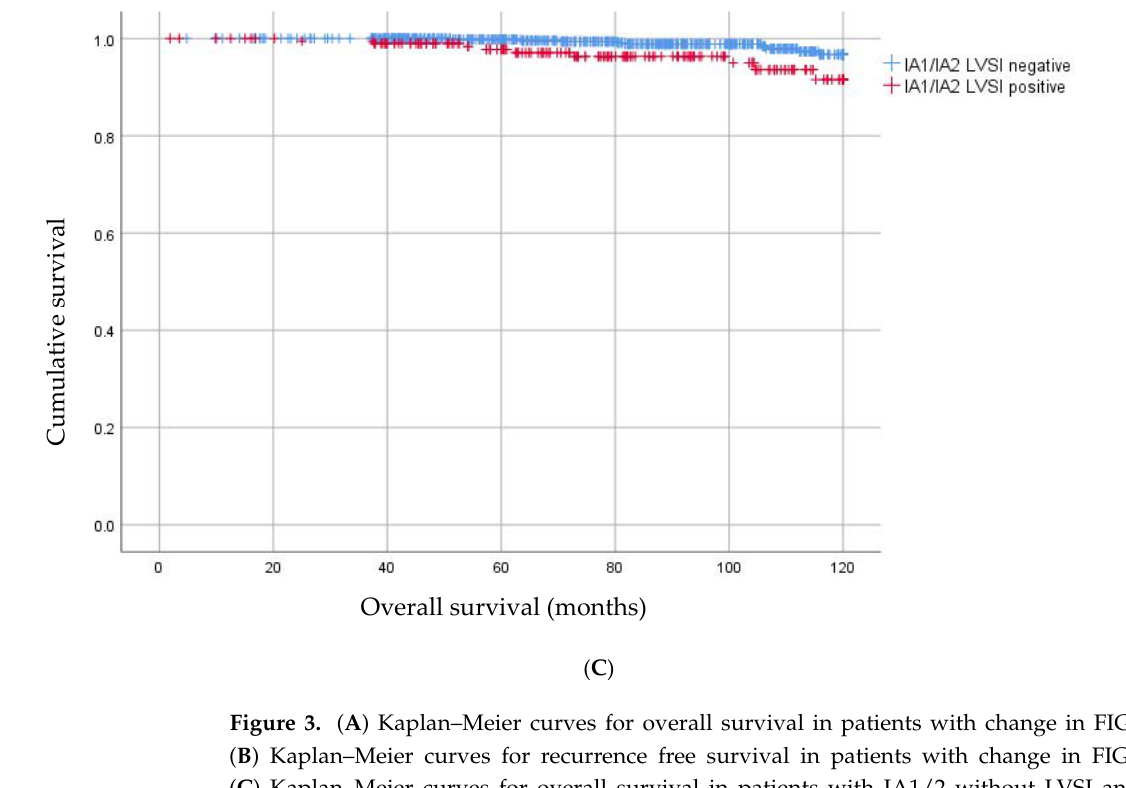
Figure 3. ( A ) Kaplan – Meier curves for overall survival in patients with change in FIGO stage. ( B ) Kaplan – Meier curves for recurrence free survival in patients with change in FIGO stage. ( C ) Kaplan – Meier curves for overall survival in patients with IA1/2 without LVSI and IA1/2 with LVSI. One hundred and seven patients (4.7%) had died of disease. Patients who were macro-invasive IB1 in the FIGO 2018 staging (HR 2.54, 95% CI 1.22 – 5.29; p = 0.01). Ten Table 3. Parametrial invasion and clinical characteristics in patients who underwent a and 89.2% for FIGO 2018 IB2, respectively.